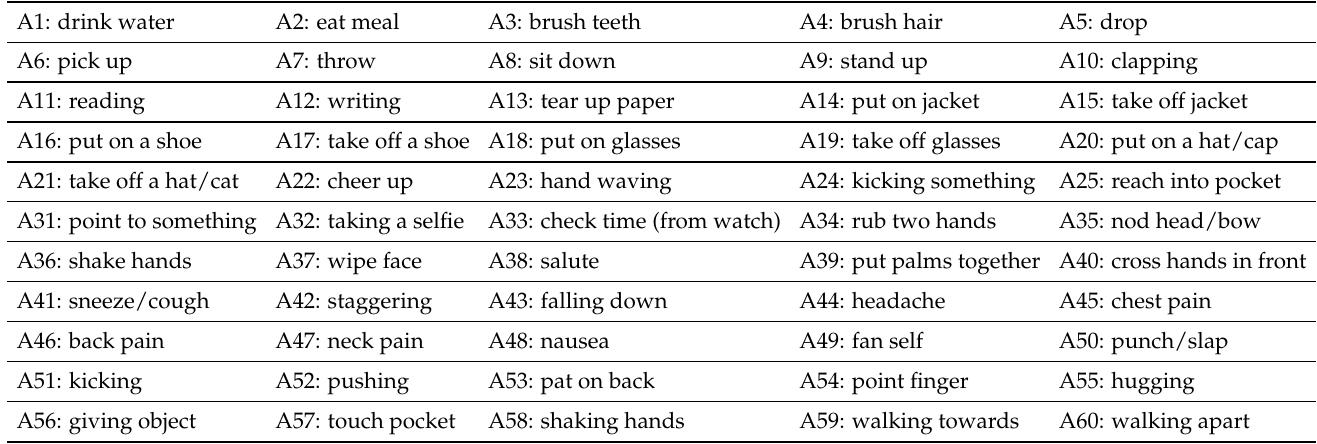
Table 1. Select the test action